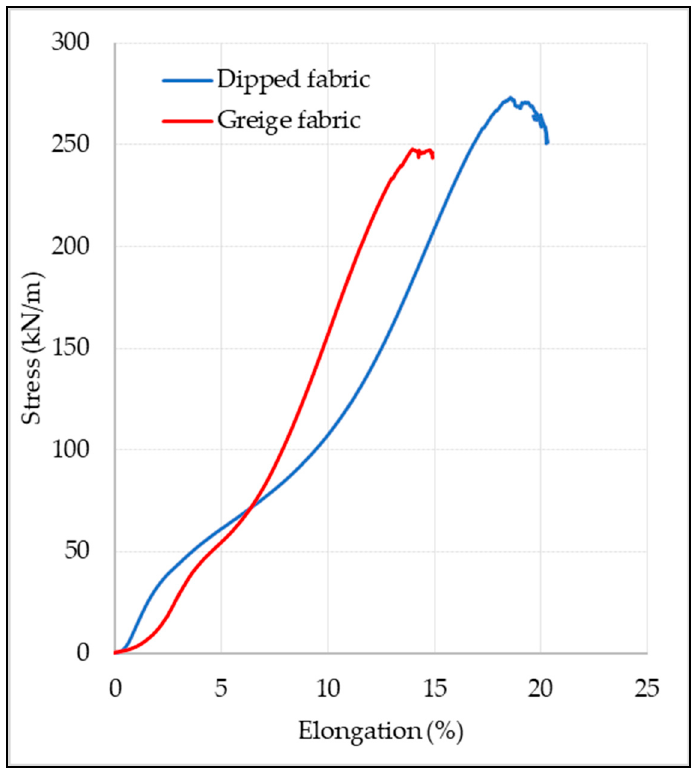
Figure 8. Stress ‐ percentage elongation curve of EP200 greige and dipped fabric samples. Figure 8. Stress-percentage elongation curve of EP200 greige and dipped fabric